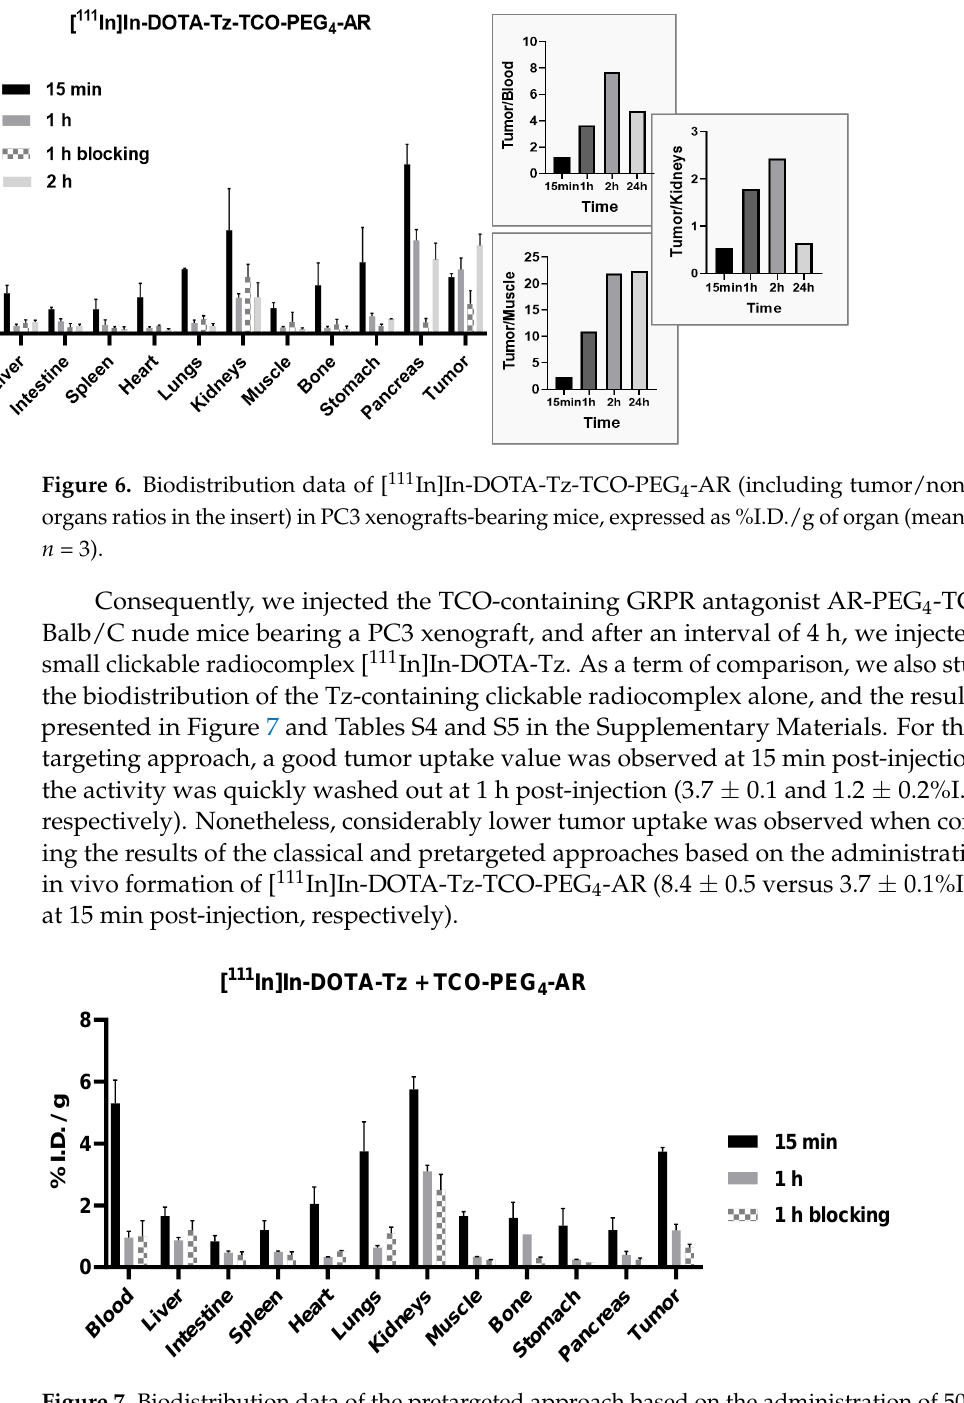
Figure 7. Biodistribution data of the pretargeted approach based on the administration of 50 µg of the AR-PEG 4 -TCO peptide, followed by a 4 h later injection of the clickable radiocomplex [ 111 In]In-DOTA-Tz in PC3 xenografts-bearing mice, expressed as % I.D./g of organ (mean ± S.D., n = 3).